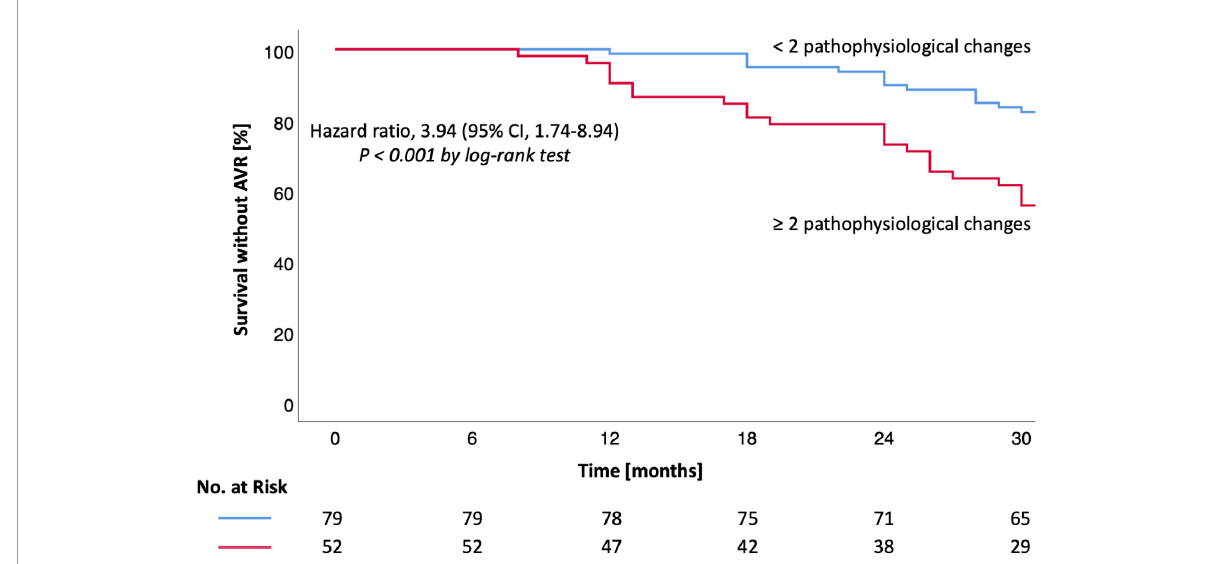
FIGURE1 Kaplan-Meier estimates for survival without AVR in moderate AS. Kaplan-Meier estimates are shown for the primary outcome (survival without AVR). CI denotes confidence interval. Hazard ratio and CI were calculated by cox proportional-hazards model (log-rank test). A P -value < 0.05 was considered to indicate statistical significance. AS, aortic valve stenosis; AVR, aortic valve replacement.